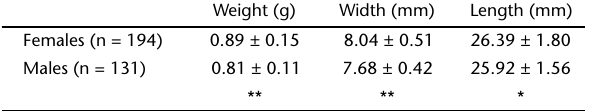
Table V. Weight, width and length of Agrotis malefida pupae (means and standard errors), reared under controlled conditions (25 ± 1°C, 70 ± 10% RH and 14 hours photo phase), including comparisons on females and males using a t-test, at a confidence level of